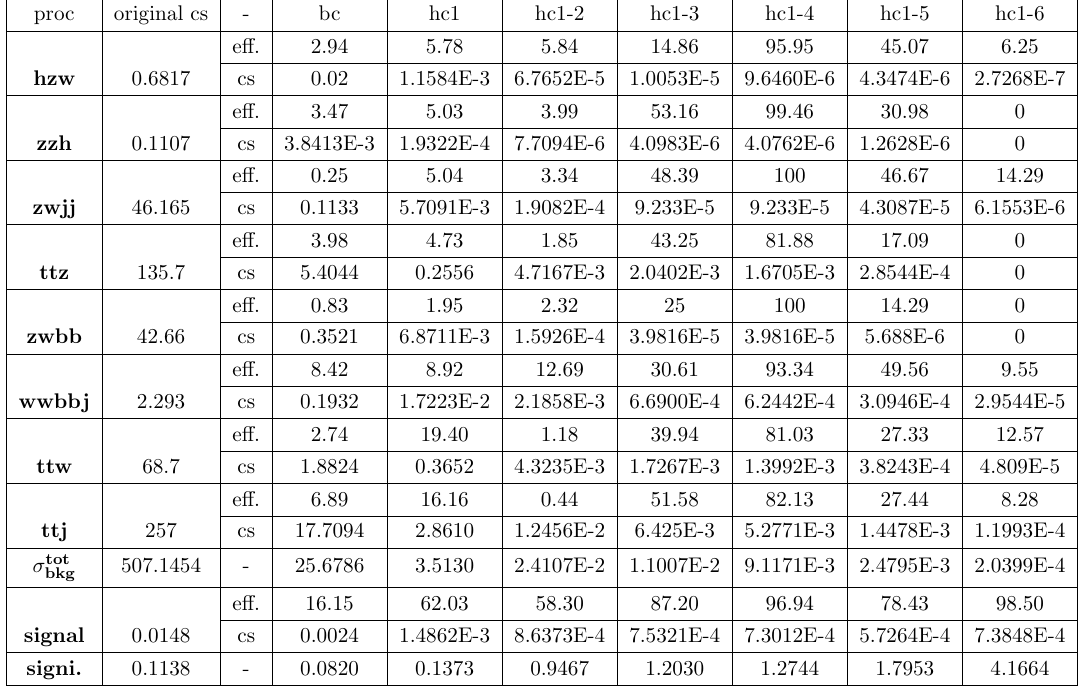
Table 5 . Cut (cid:13)ow table for pp ! H (cid:6)(cid:6) H (cid:7) ! ‘ (cid:6) ‘ (cid:6) hW (cid:7) under basic cuts (bc) and hard cuts (hc) with integrated luminosity of 30 ab (cid:0) 1 . Here and in table 9, we use the same abbreviations: \proc." for \processes"; \E" for \base 10 exponential function"; \cs" for \cross section" with unit fb ; \e(cid:11)." for \e(cid:14)ciency" in percent; \signi." for \signi(cid:12)cance" and \hci-j" means \applying hard cuts i, (cid:1) (cid:1) (cid:1) ,